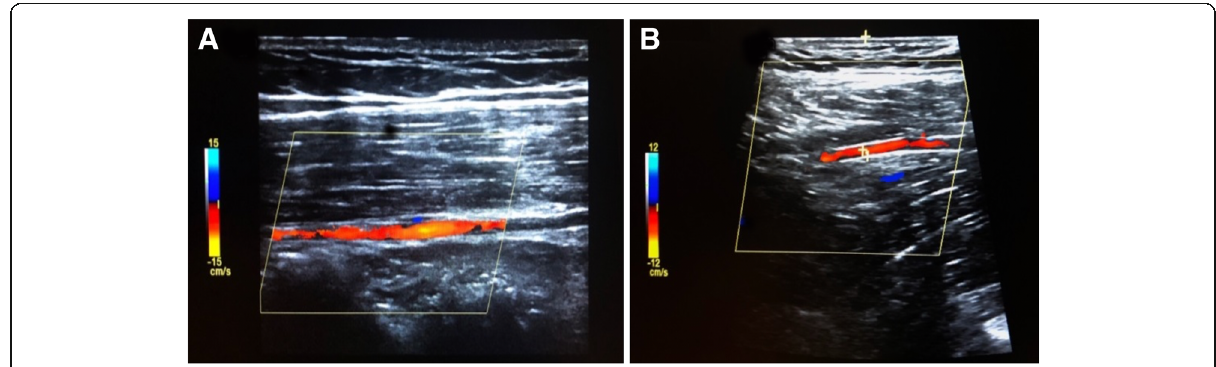
Fig. 2 Mapping the a right inferior epigastric artery (IEA) and b deep circumflex iliac artery (DCIA) in a healthy volunteer using Doppler